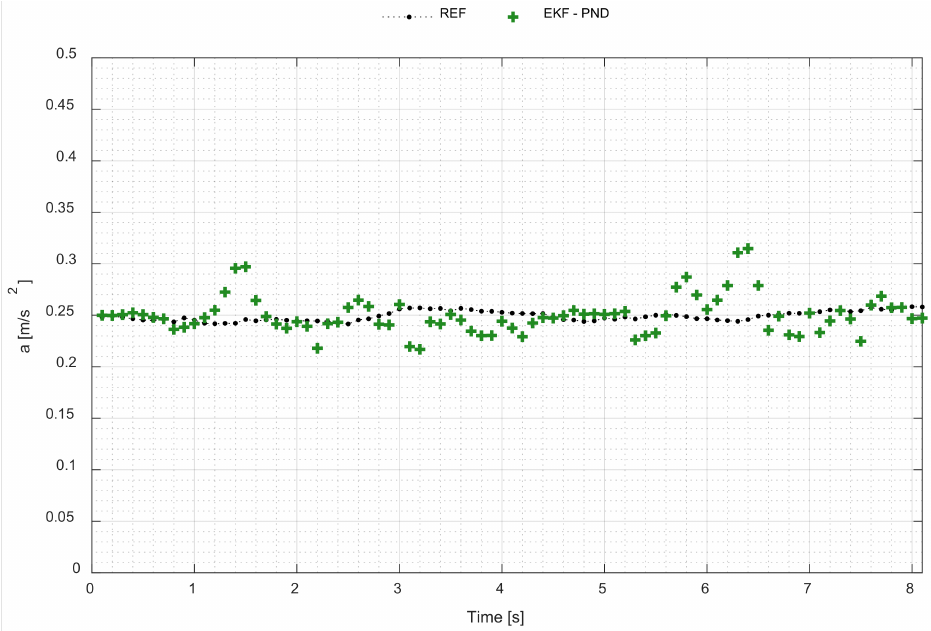
Figure 15. Acceleration estimated with EKF-PND.